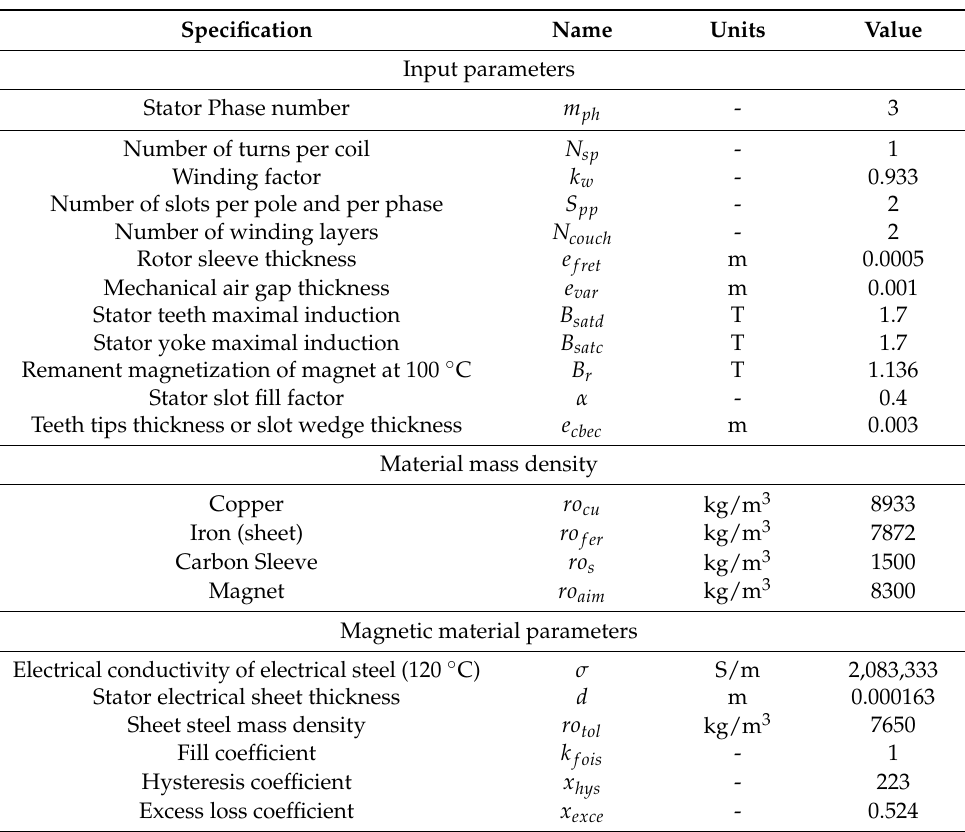
Table 3. Input constant